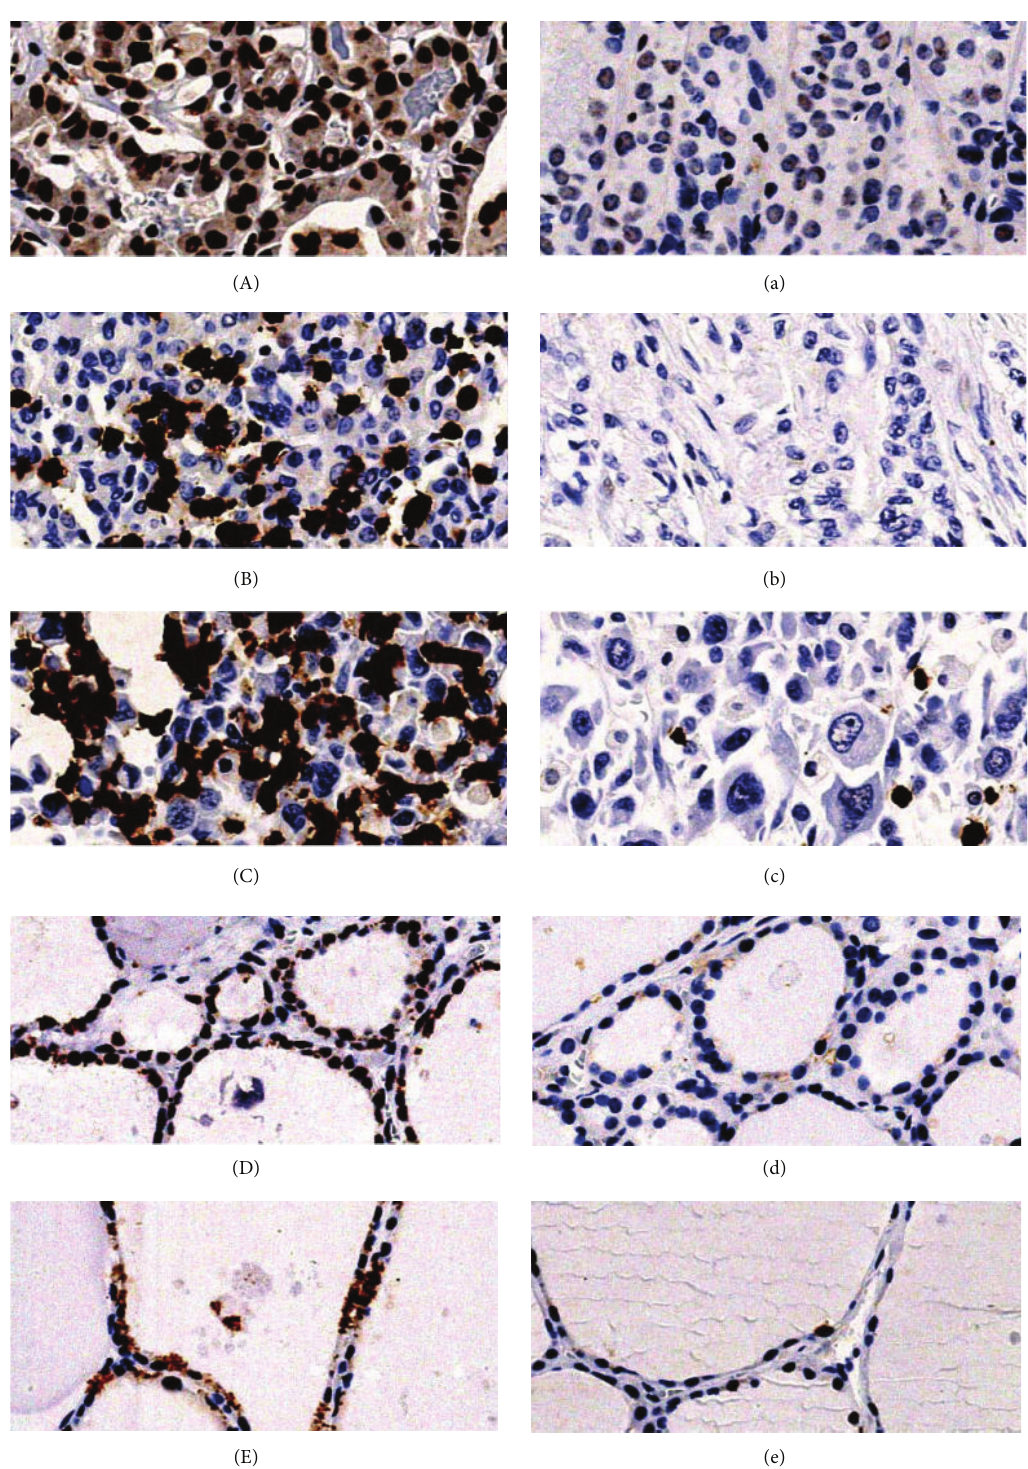
Figure 2: ATM expression in thyroid tissues. (A) High expression of ATM in well differentiated thyroid cancer. (a) Low expression of ATM in well differentiated thyroid cancer. (B) High expression of ATM in poorly differentiated thyroid cancer. (b) Low expression of ATM in poorly differentiated thyroid cancer. (C) High expression of ATM in anaplastic thyroid cancer. (c) Low expression of ATM in anaplastic thyroid cancer. (D) High expression of ATM in benign nodular goiter tissues. (d) Low expression of ATM in benign nodular goiter tissues. (E) High expression of ATM in normal adjacent tissues. (e) Low expression of ATM in normal adjacent tissues. Original magnification of all images, ×